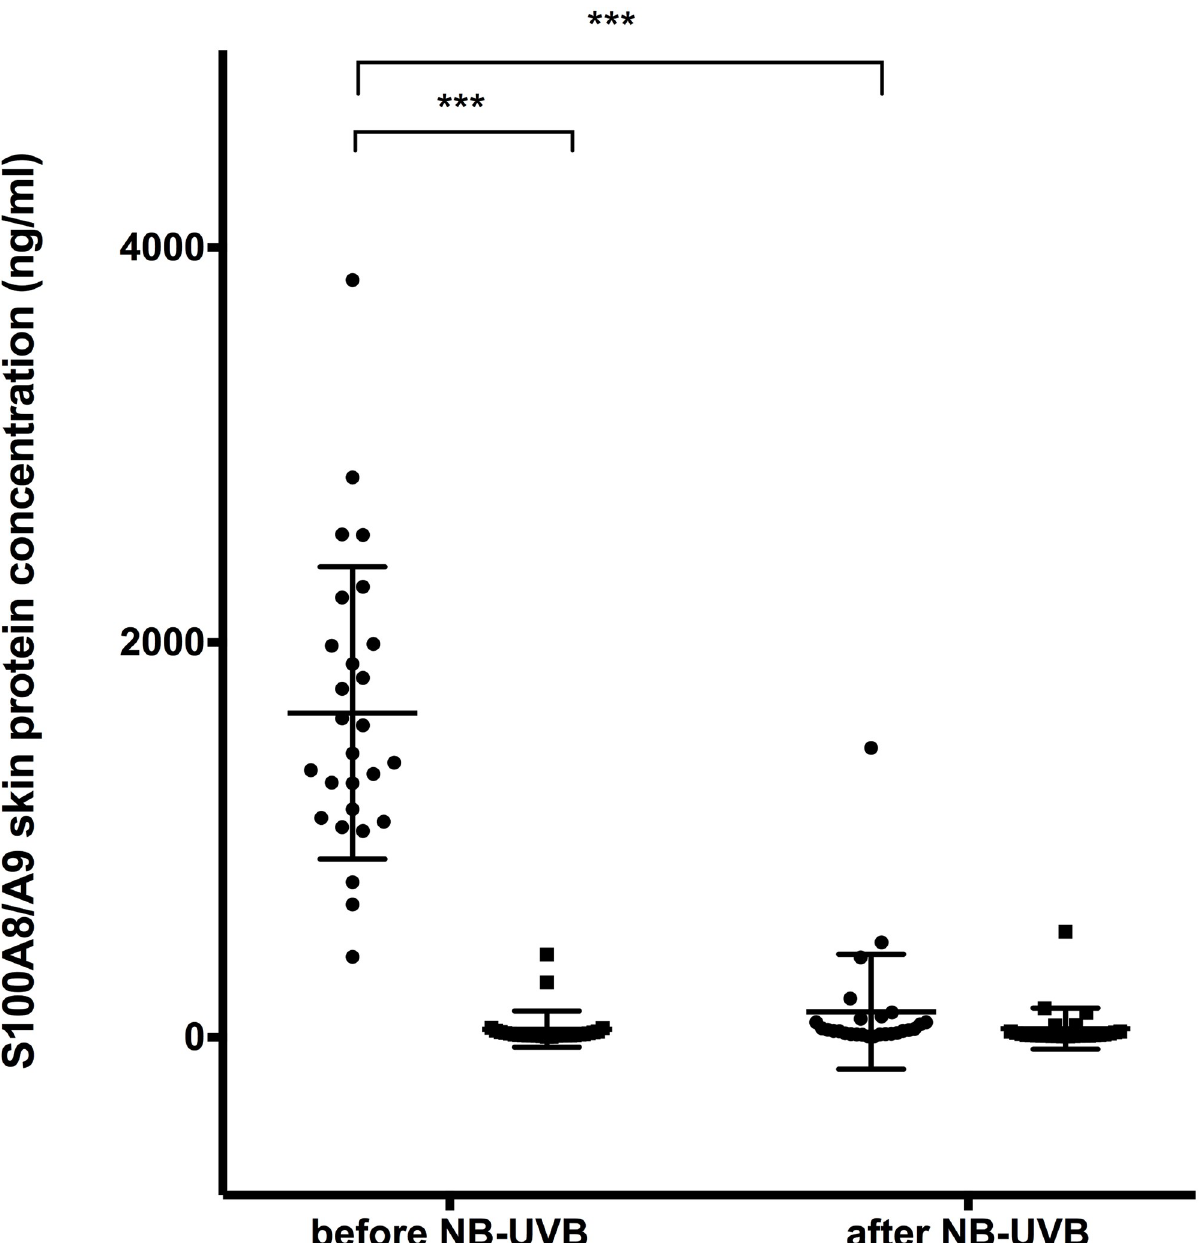
Fig 4. Skin protein levels of S100A8/A9 heterocomplex in lesional and non-lesional skin of patients with psoriasis before and after NB-UVB treatment. n = 27, ● = lesional skin, ■ = non-lesional skin. ( ��� p < 0.001).